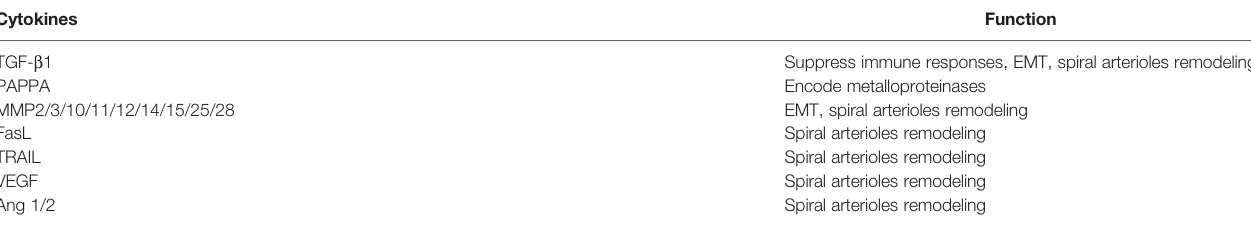
TABLE 3 | Cytokines involved in the EMT, invasion and spiral arterioles remodeling. Cytokines Function TGF- b